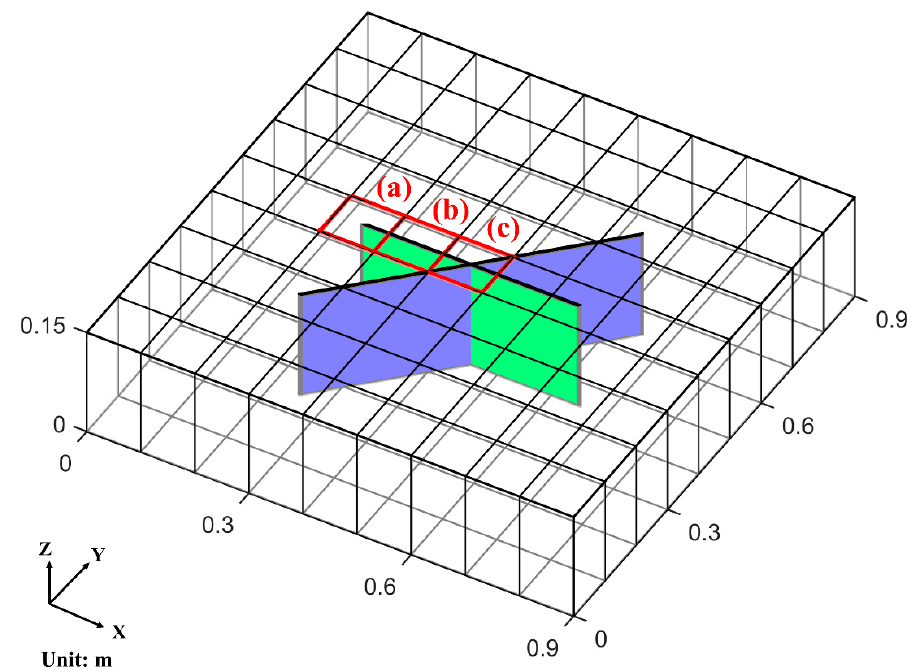
Figure 4. The fractured reservoir in Case 1. The 9 × 9 grids showed a possible gridding choice for iEDFM or EDFM.